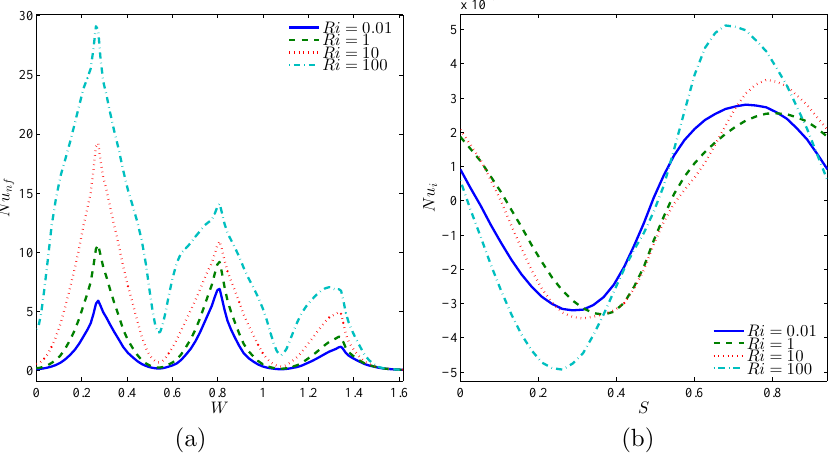
Figure 8. Variations of local Nusselt number interfaces with ( a ) W and ( b ) S for different Ri at Case 1 ( Ω ), φ = 0.02, N = 3, and R =